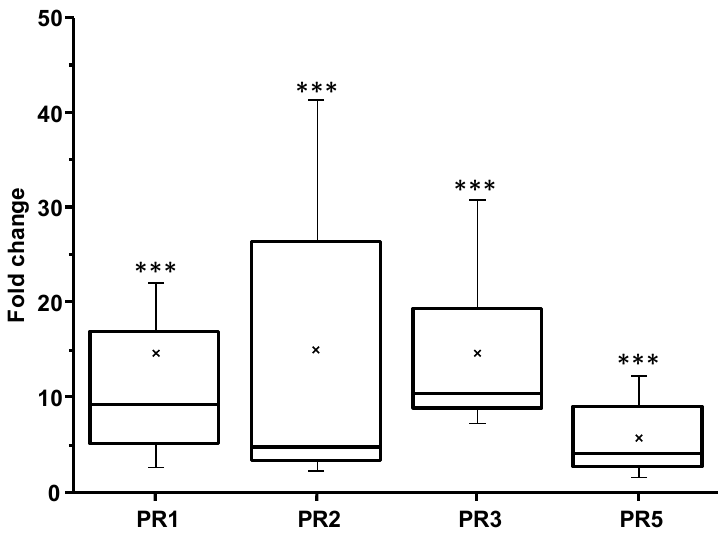
Figure 3. PR transcript accumulation in tobacco leaves 4 days after RME1-spraying. Transcripts were quantified by real-time RT-PCR in treated leaves. Values are expressed relative to control (acidic water treatment) values. Each experiment was performed in triplicate (2 leaves per plant, 3 plants). Asterisks indicate significant differences compared with the control (***) p < 0.001.